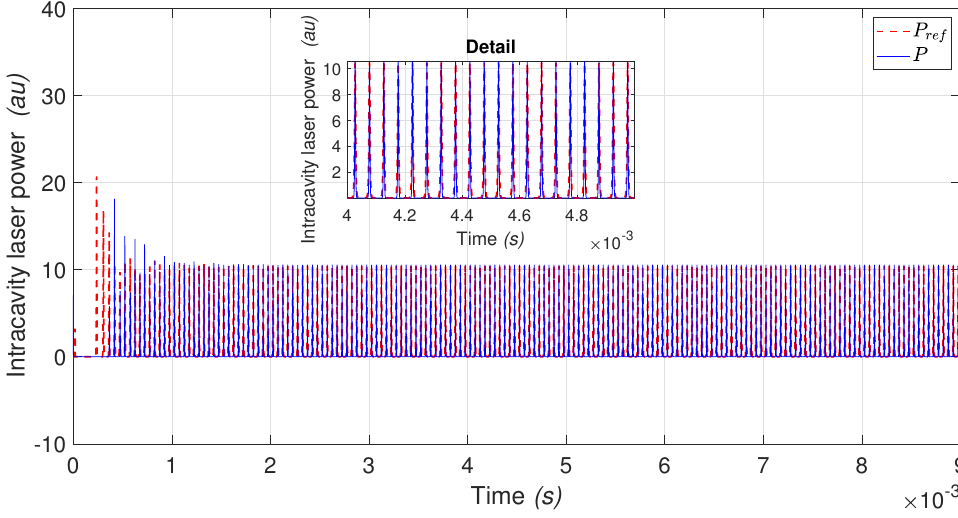
Figure 10. EDFL tracking to P 4. Figure 11 shows the EDFL behavior toward the period-5 ( P 5) orbit. P ref is represented by the red dashed line, and P by the blue continuous line. This figure shows the tracking trajectory of the EDFL ( P ) to the reference ( P ref ), where the reference is P 5 generated by the exogenous system. The inset illustrates a rapid convergence. The chosen gain parameters are k 1 = − 3.9 × 10 12 , λ 1 = 0.001, and α 1 =